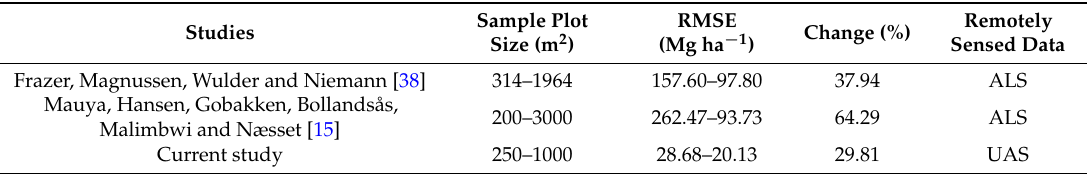
Table 6. Effect of sample plot sizes on the root mean square errors (RMSE) of biomass estimates for different